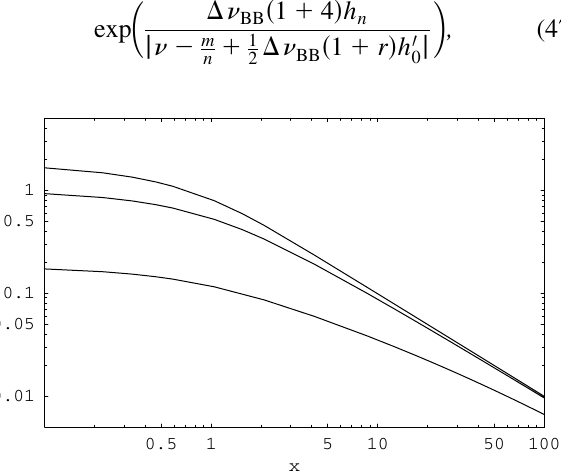
FIG. 2. Function @h